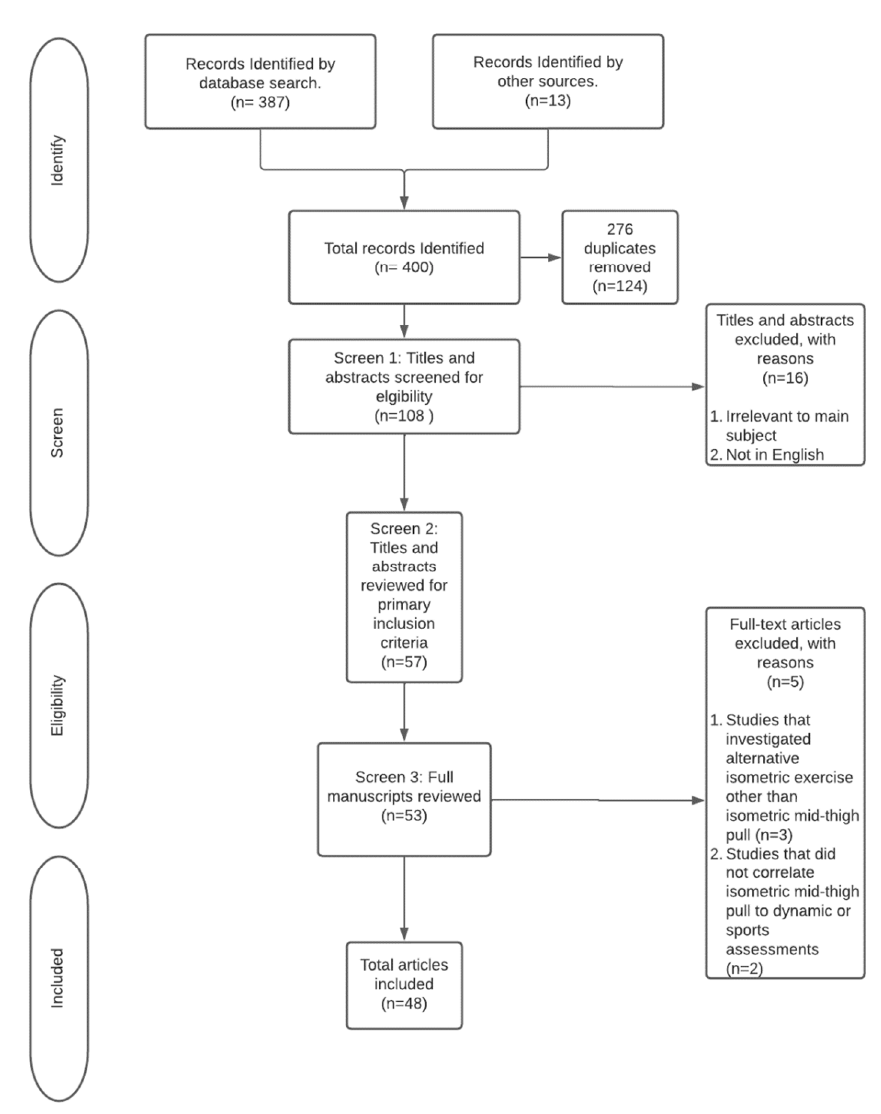
Figure 1. PRISMA flow diagram detailing inclusion and exclusion process.